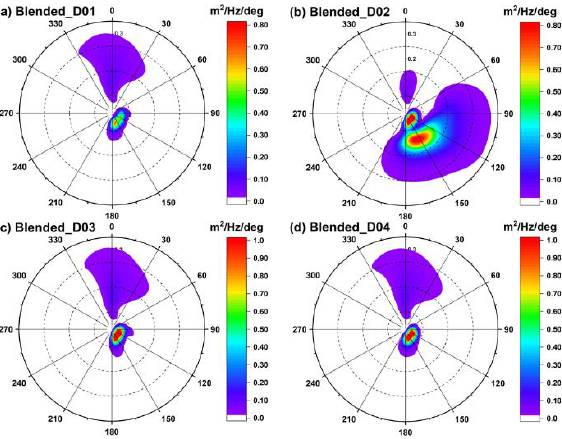
Figure 27. Comparison of the directional wave spectra at the Eluanbi wave buoy at 00:00 on 27